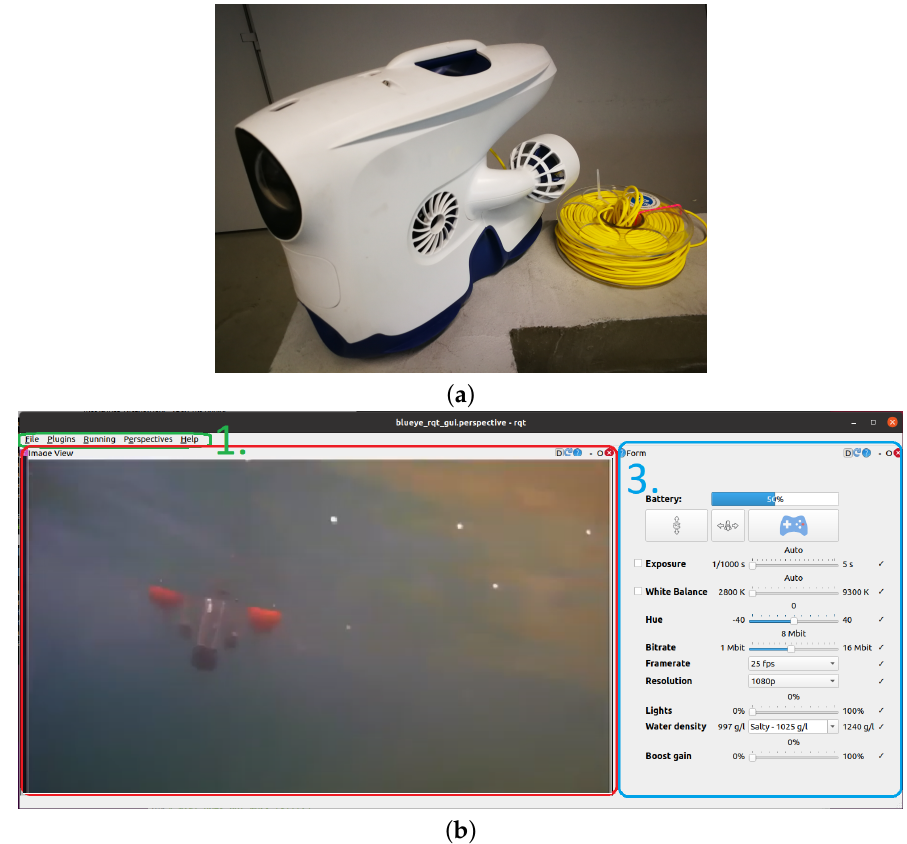
Figure 8. ( a ) Blueye Pro ROV. ( b ) Graphical user interface of Blueye-ROS2